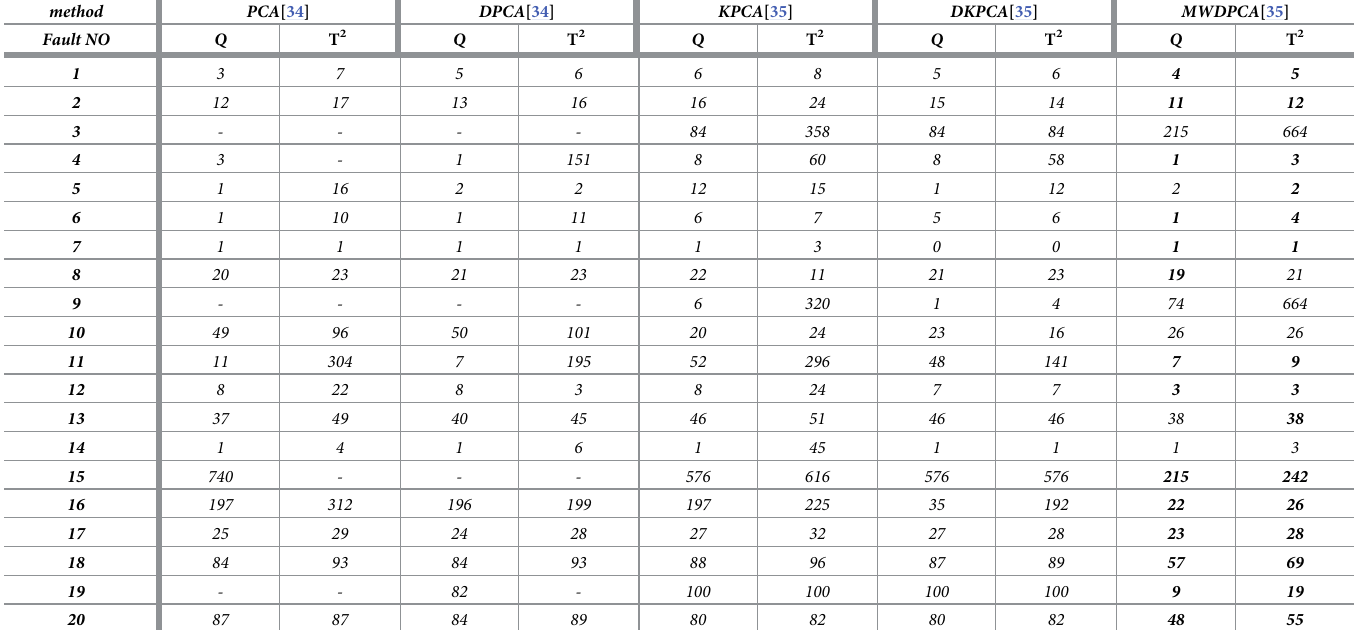
Table 4. Comparison of DTD for MWDPCA with other methods